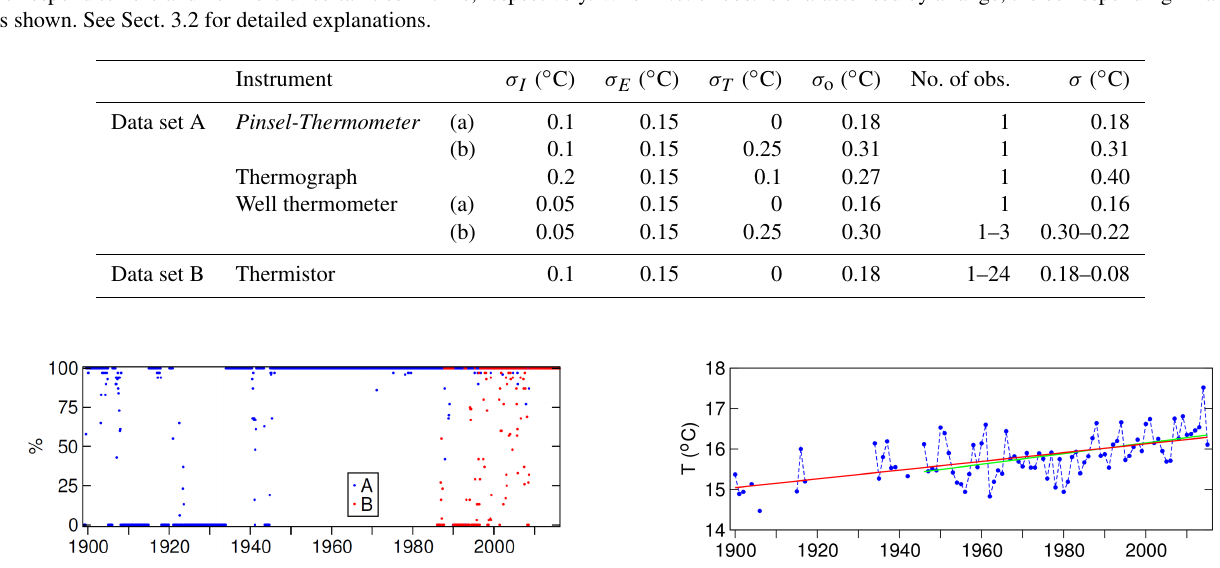
Figure 5. Annual mean sea temperature at 2m depth from 1899 to 2015 (blue dots and dashed lines) and linear trends for 1899 to 2015 (red line) and 1946 to 2015 (green